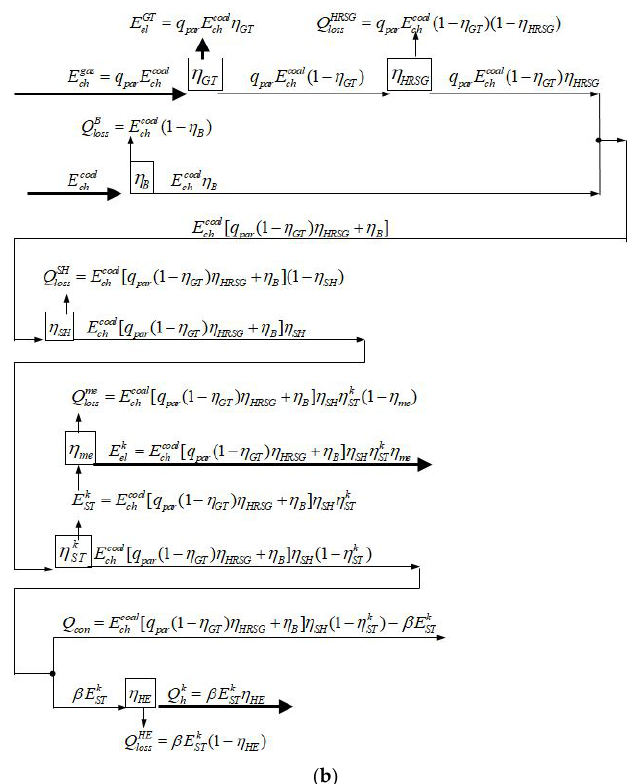
Figure 2. Energy balance of a dual-fuel gas-steam combined heat and power plant in a parallel system: ( a ) comprising steam-backpressure steam turbine; ( b ) comprising steam-extraction and condensing steam turbine. Where: β —parameter determining the ratio of heat contained in the bleeding heating steam supplying the HE heat exchangers to the mechanical energy generated in the steam-condensing steam turbine (parameter β is the inverse of the steam turbine coefficient [21–23]); HE η —energy efficiency of heat exchangers station.